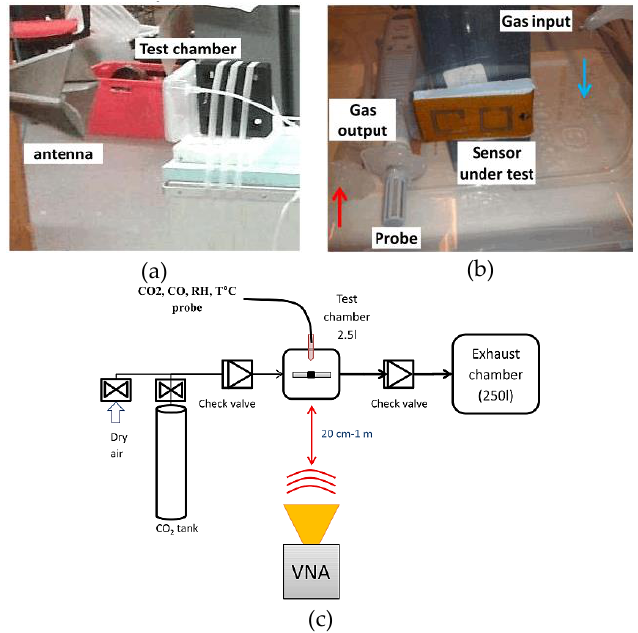
Figure 8. Experimental process: ( a ) view of the antenna in front of the test chamber; ( b ) view of the test chamber; and ( c ) description of the set-up for gas measurement [51].